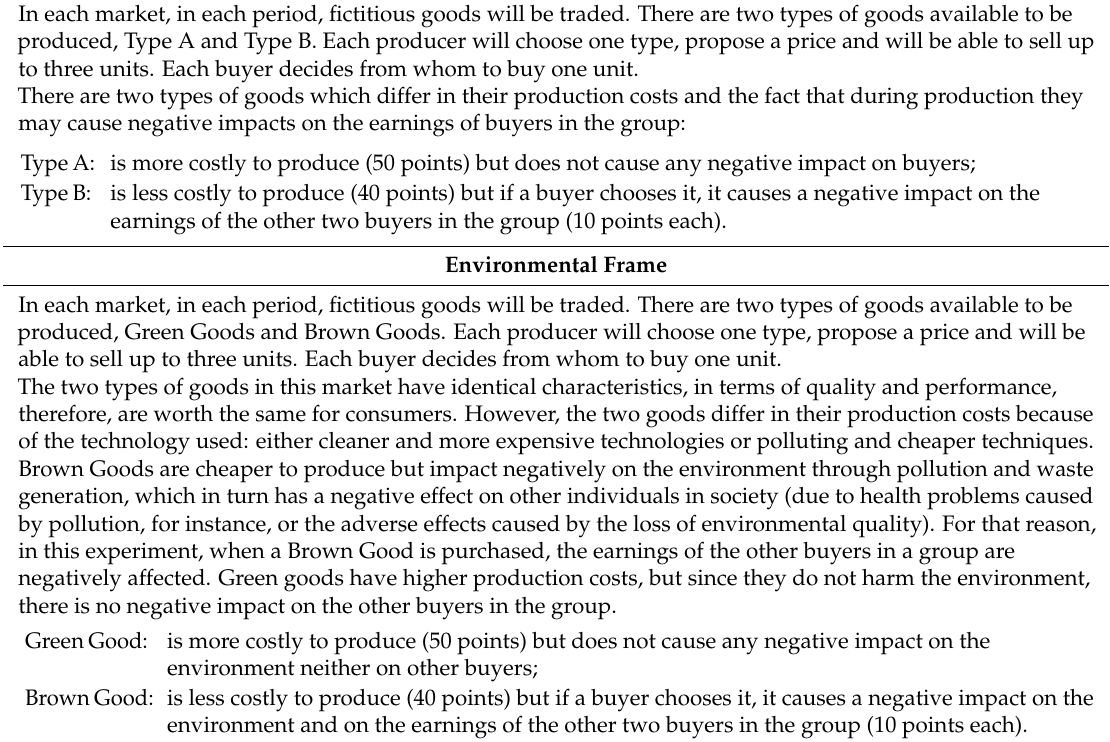
Table 1. Instructions about the rules of the market in the two experimental treatments. Neutral Frame